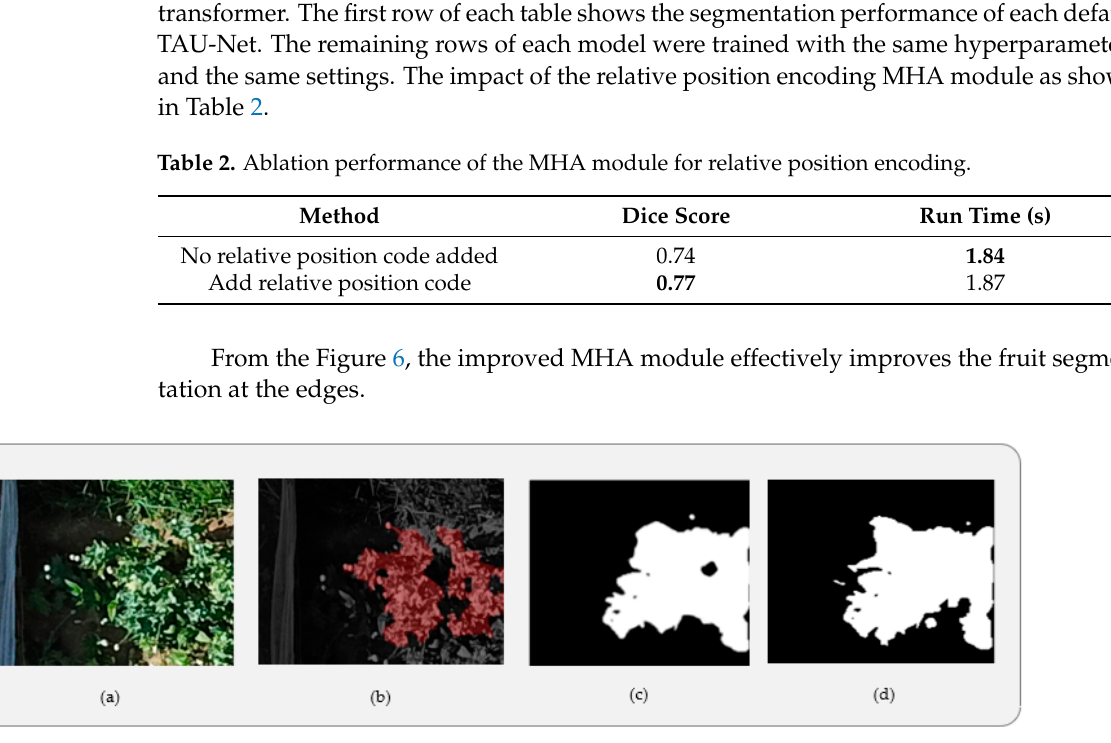
Figure 6. ( a ) Poppy image, ( b ) ground truth and segmentation results of ( c ) TAU-Net without RPE, ( d ) TAU-Net with the RPE modified MHA module. ( d ) TAU-Net with the RPE modified MHA